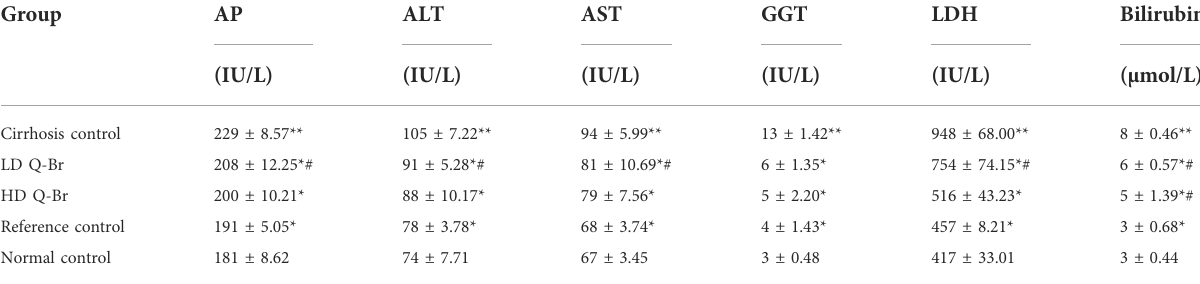
TABLE 2 Effect of Q-Br treatment on the liver biochemistry of the rats after 15 weeks in sub-chronic liver injury induced by TAA.